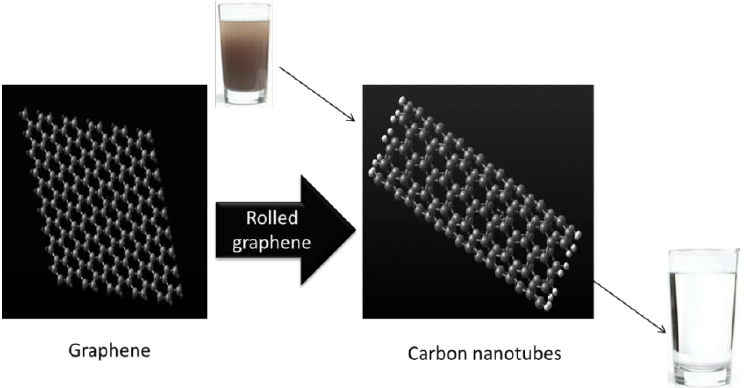
Figure 6. Use of CNTs for water purification.